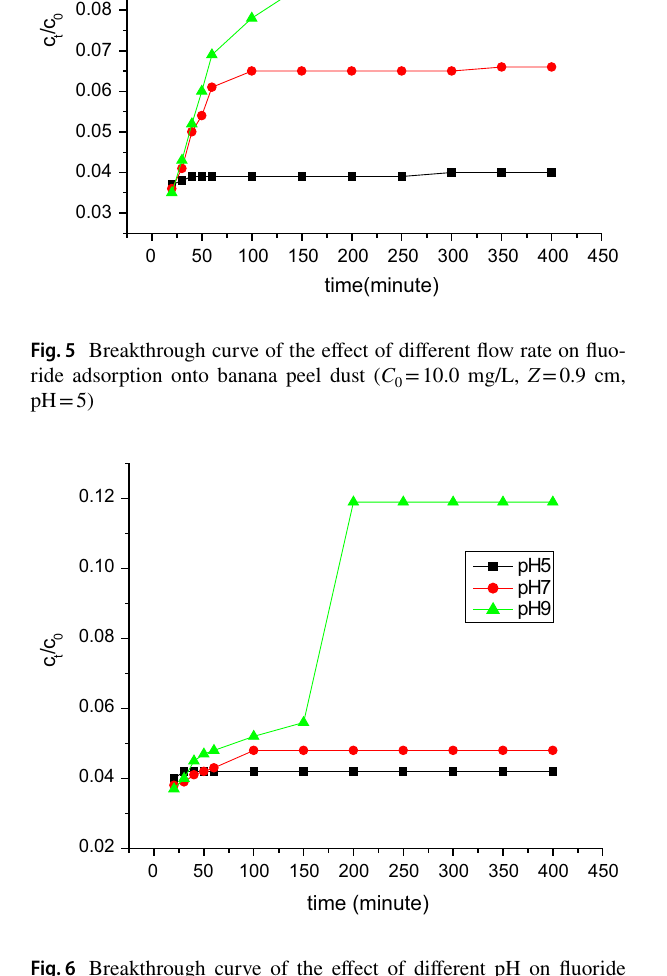
Fig. 6 Breakthrough curve of the effect of different pH on fluoride adsorption onto banana peel dust ( v = 3.4 ml/min, C 0 = 10.0 mg/L, Z = 2 g)